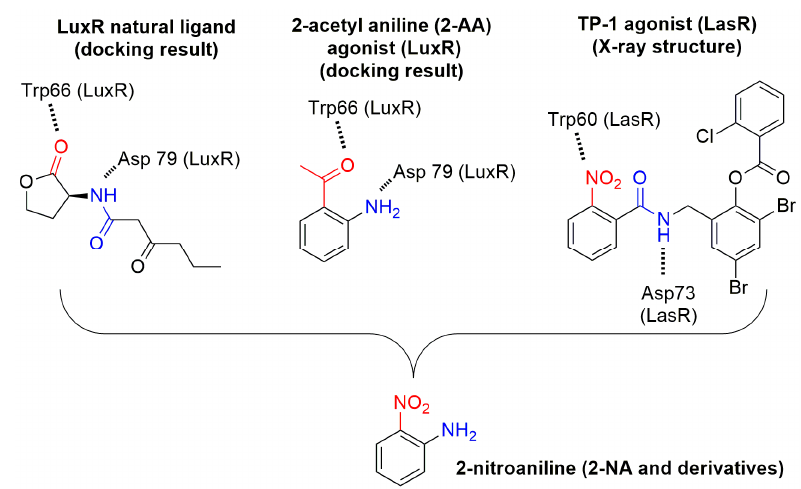
Figure 1. Structure-based design of 2-nitroaniline ( 2-NA ) and derivatives ( 2-NA ).